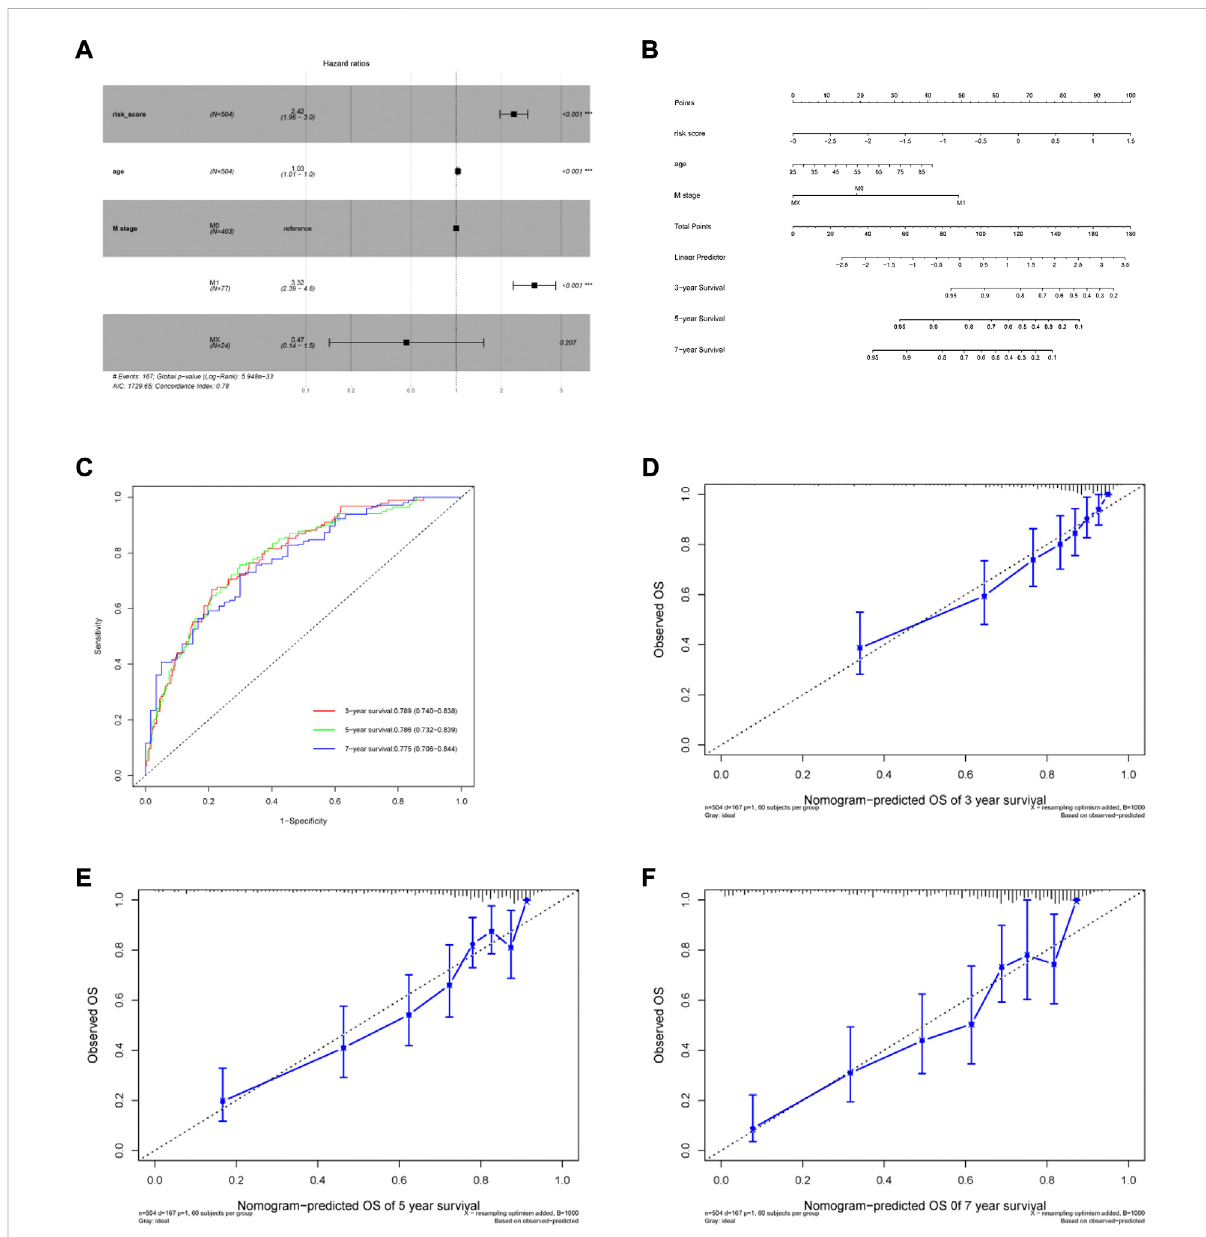
FIGURE 5 Generationofthenomogramincorporatingriskscore andclinicalparameters. (A) Multivariable Coxproportional hazardmodel. (B) Nomogram for predicting 3-, 5- and 7-year overall survival of ccRCC patients. (C) The time-dependent ROC curves of the nomogram for 3-, 5- and 7-year survival prediction. (D – F) Calibration curves of the nomogram prediction of 3-, 5- and 7-year OS of ccRCC